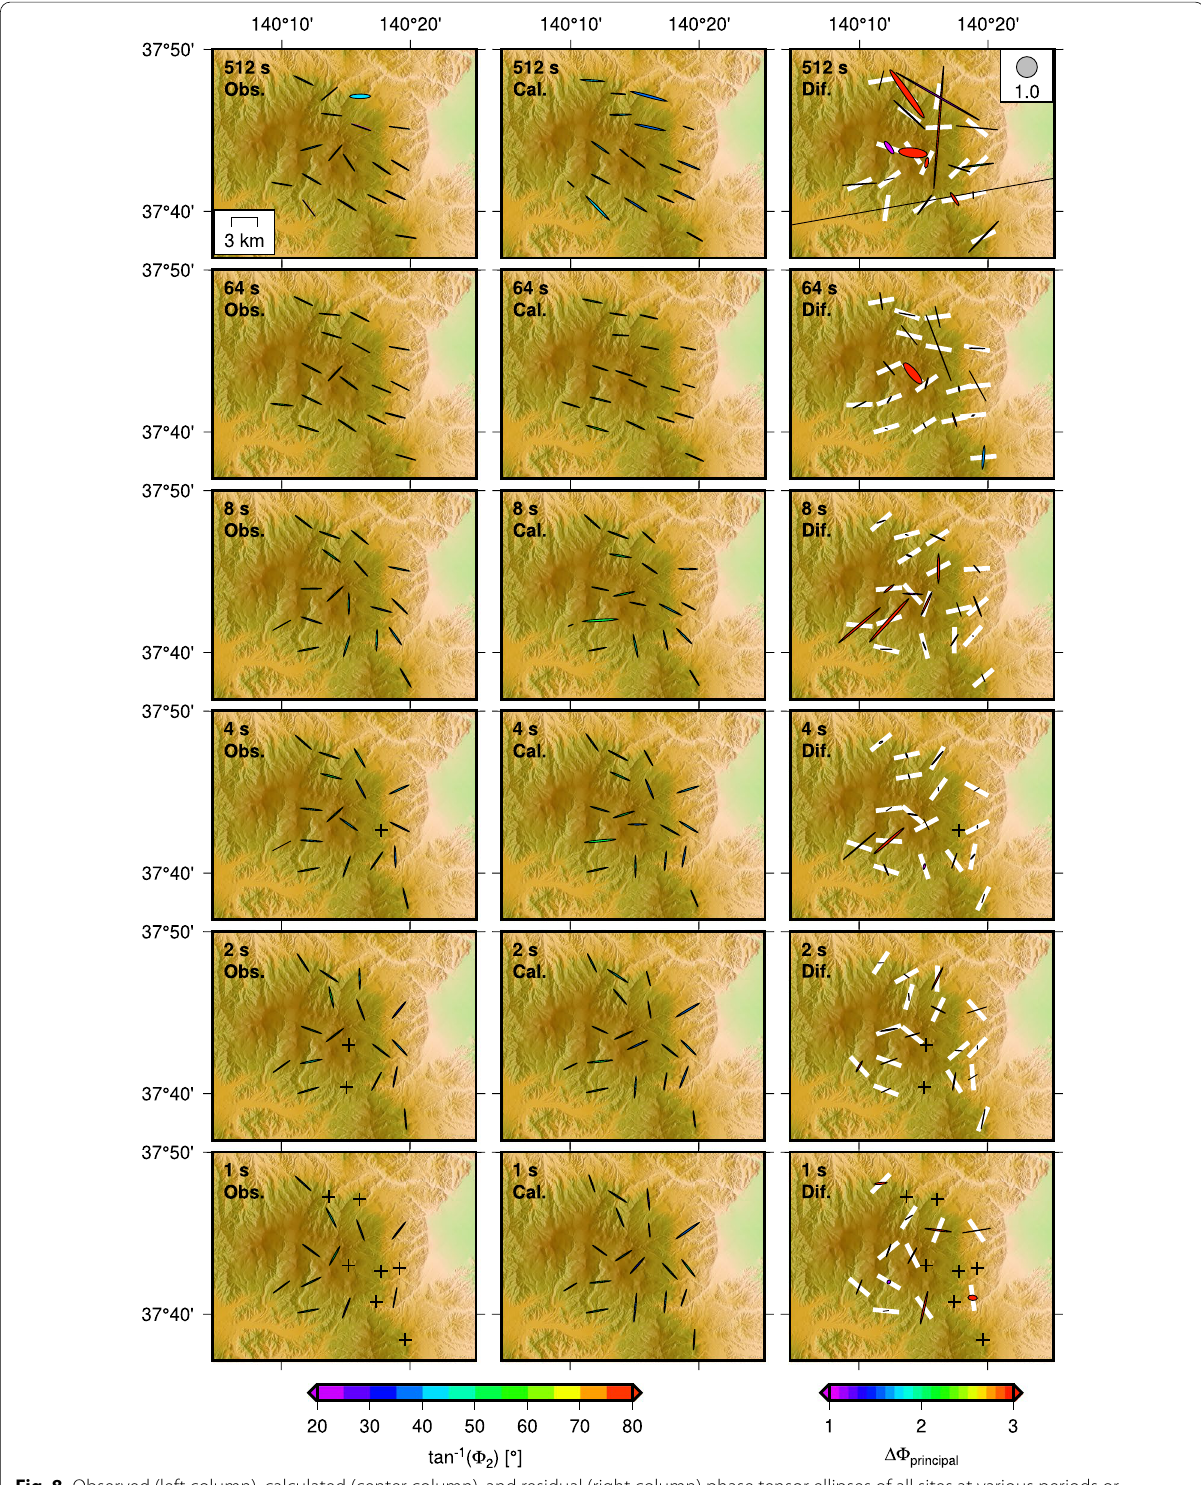
Fig. 8 Observed (left column), calculated (center column), and residual (right column) phase tensor ellipses of all sites at various periods or frequencies. The observed and calculated phase tensor ellipse magnitudes are normalized with each observed maximum principal axis magnitude at each site and period/frequency, and are filled with colors corresponding to tan − 1 ( Φ 2 ) designated by the color scale. The phase tensor residual uses the definition by Peacock et al. (2012), and these are filled with colors corresponding to Δ Φ principal (Eq. 18) designated by the color scale. Azimuth of the white bars represents α obs β obs π /2 direction (length is + +